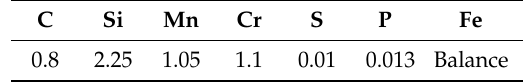
Table 1. Chemical composition of the manufactured steel (wt. %).